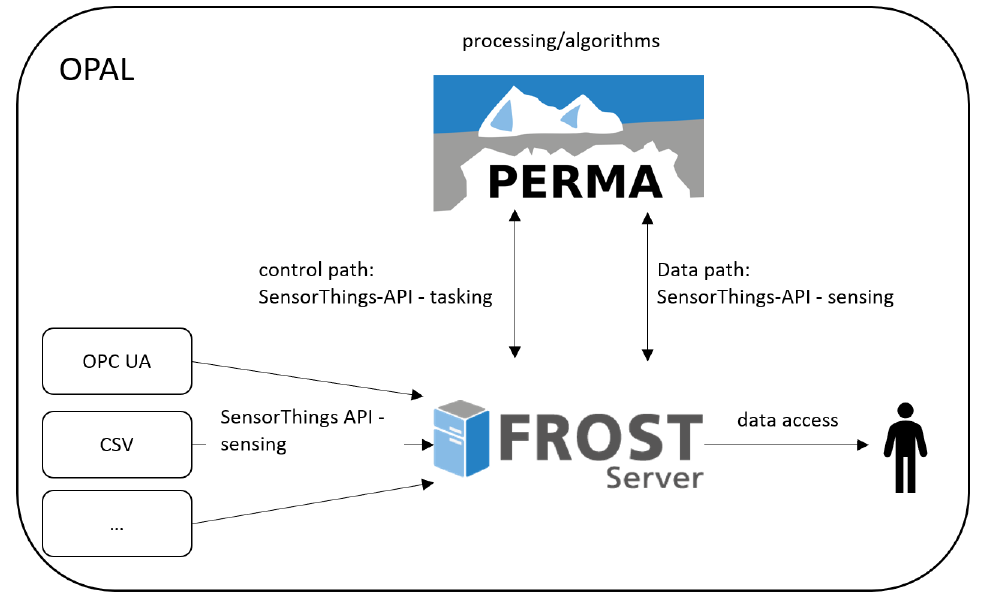
Figure 1. The OPAL